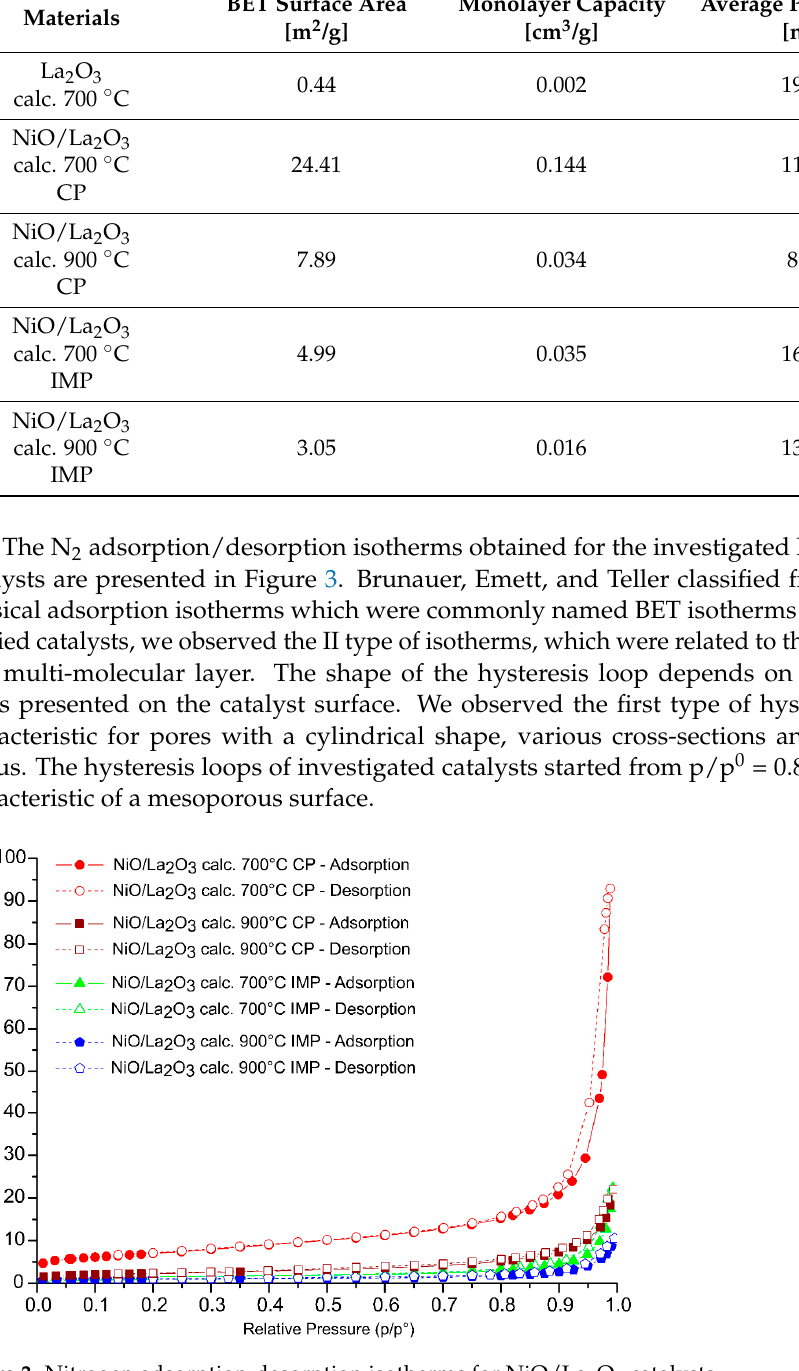
Figure 3. Nitrogen adsorption-desorption isotherms for NiO/La 2 O 3 catalysts.